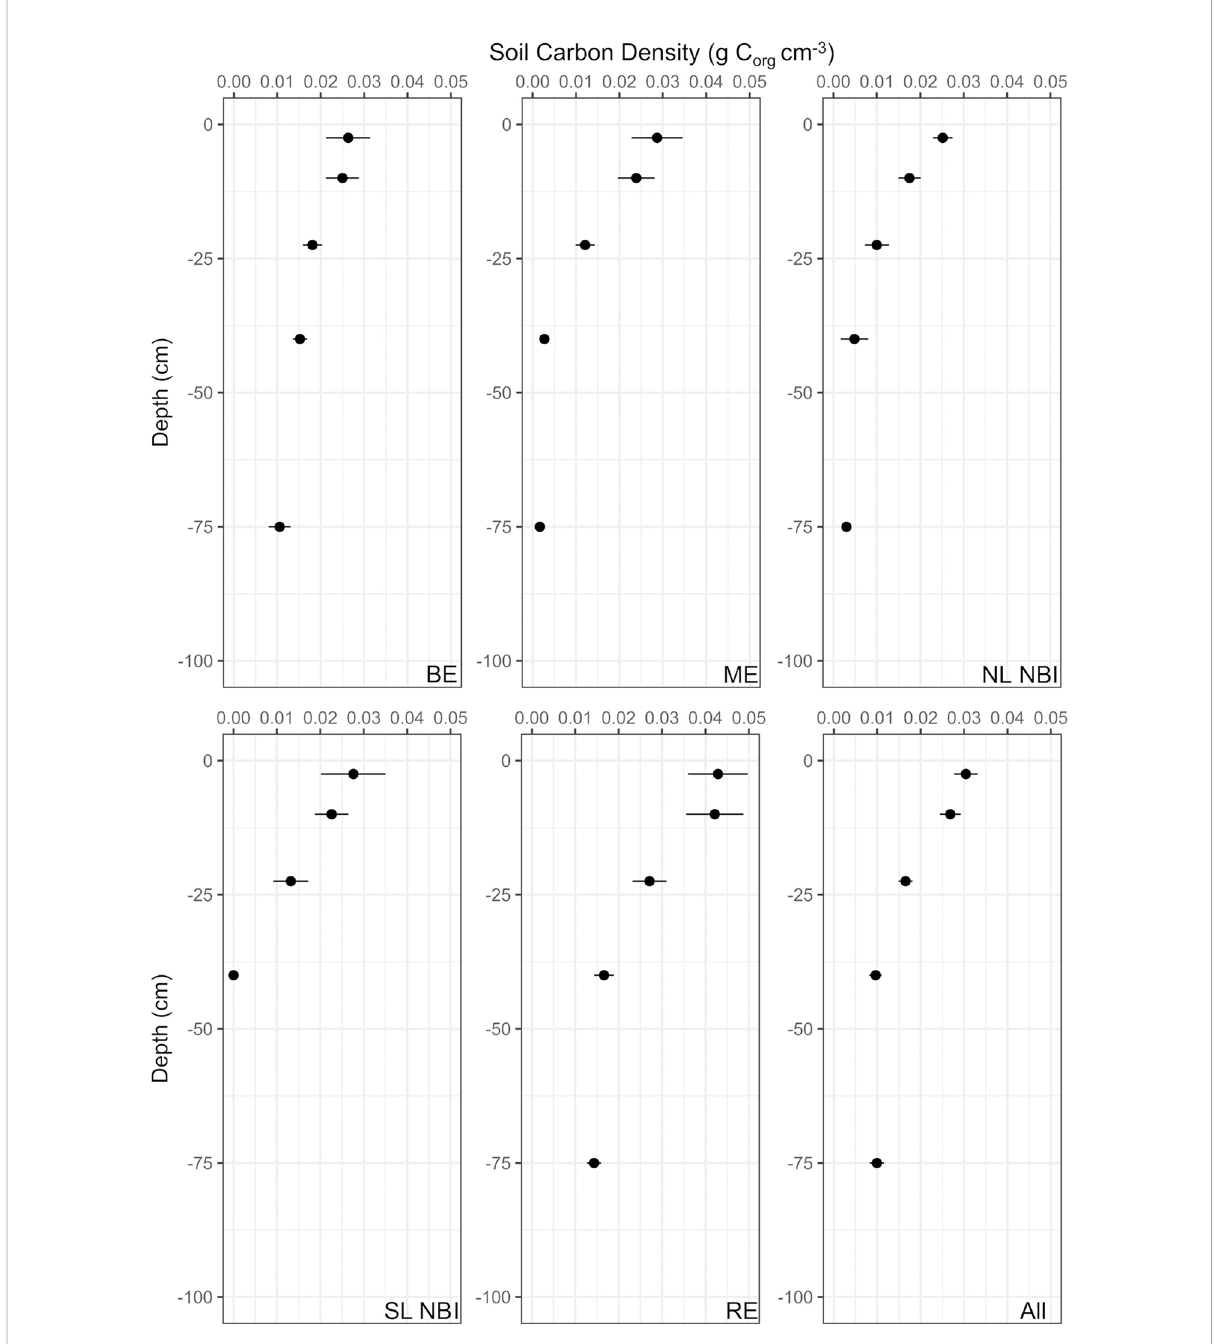
Bull Island (NL NBI); Bottom L-R: South Lagoon of NBI (SL NBI), Rogerstown Estuary (RE), and All Sites